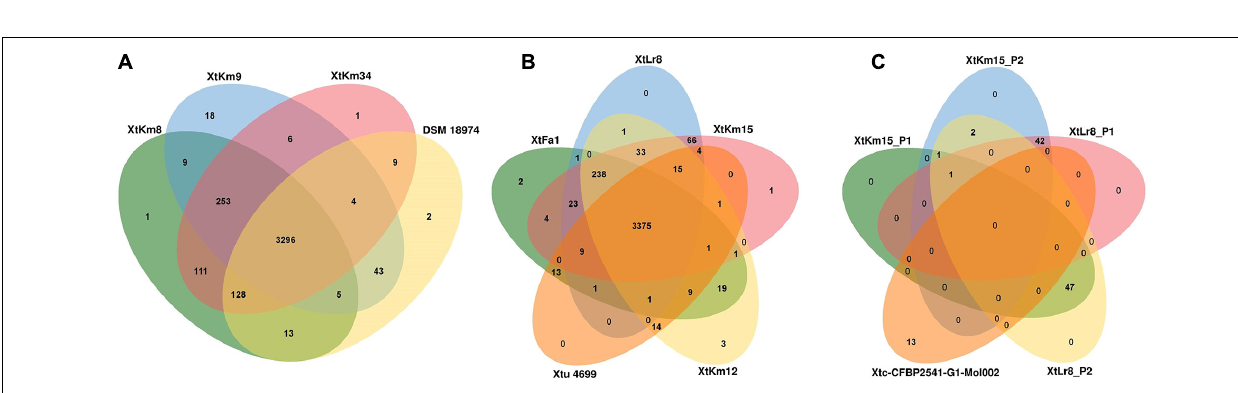
Frontiers in Microbiology |